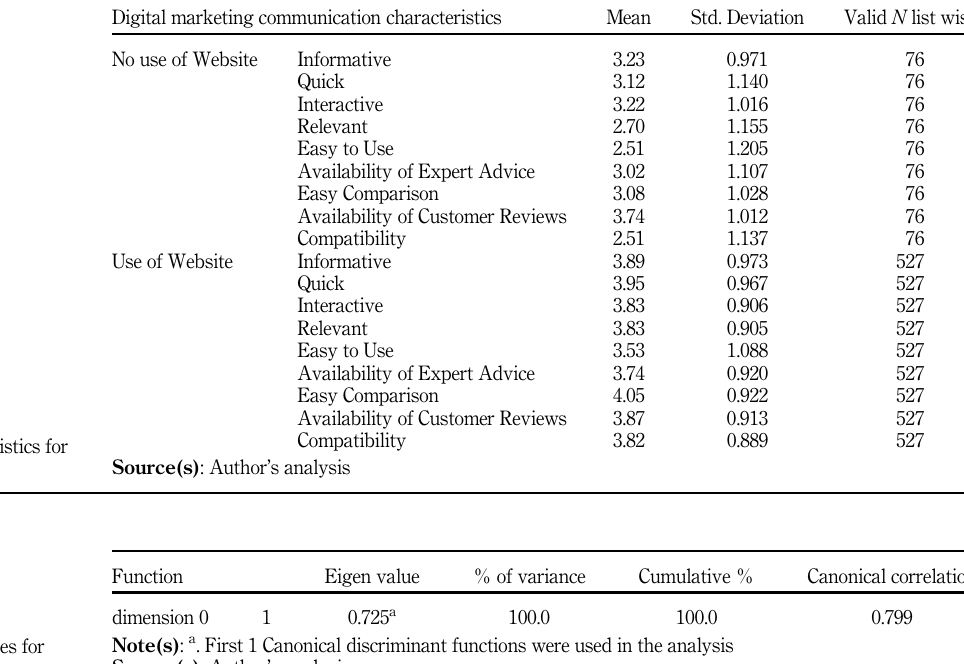
Table 3. Eigen values for